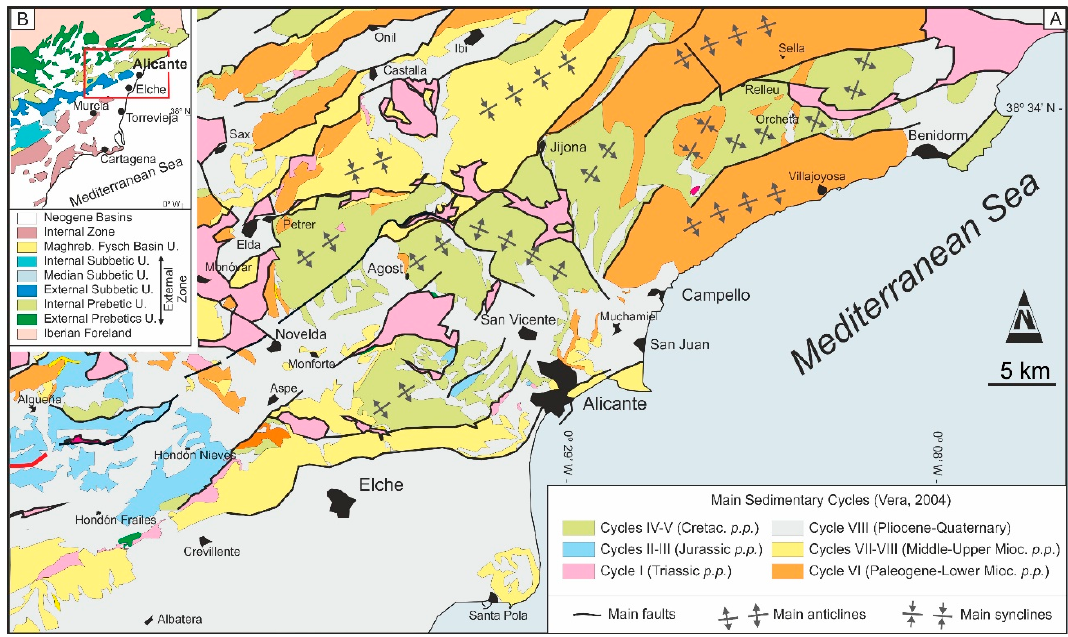
Figure 3. Geological maps of the eastern EBZ in the Alicante sector (after Reference [21]; modified). ( A ) Detailed geological map of the Alicante sector. ( B ) Structural sketch map of the Alicante sector.